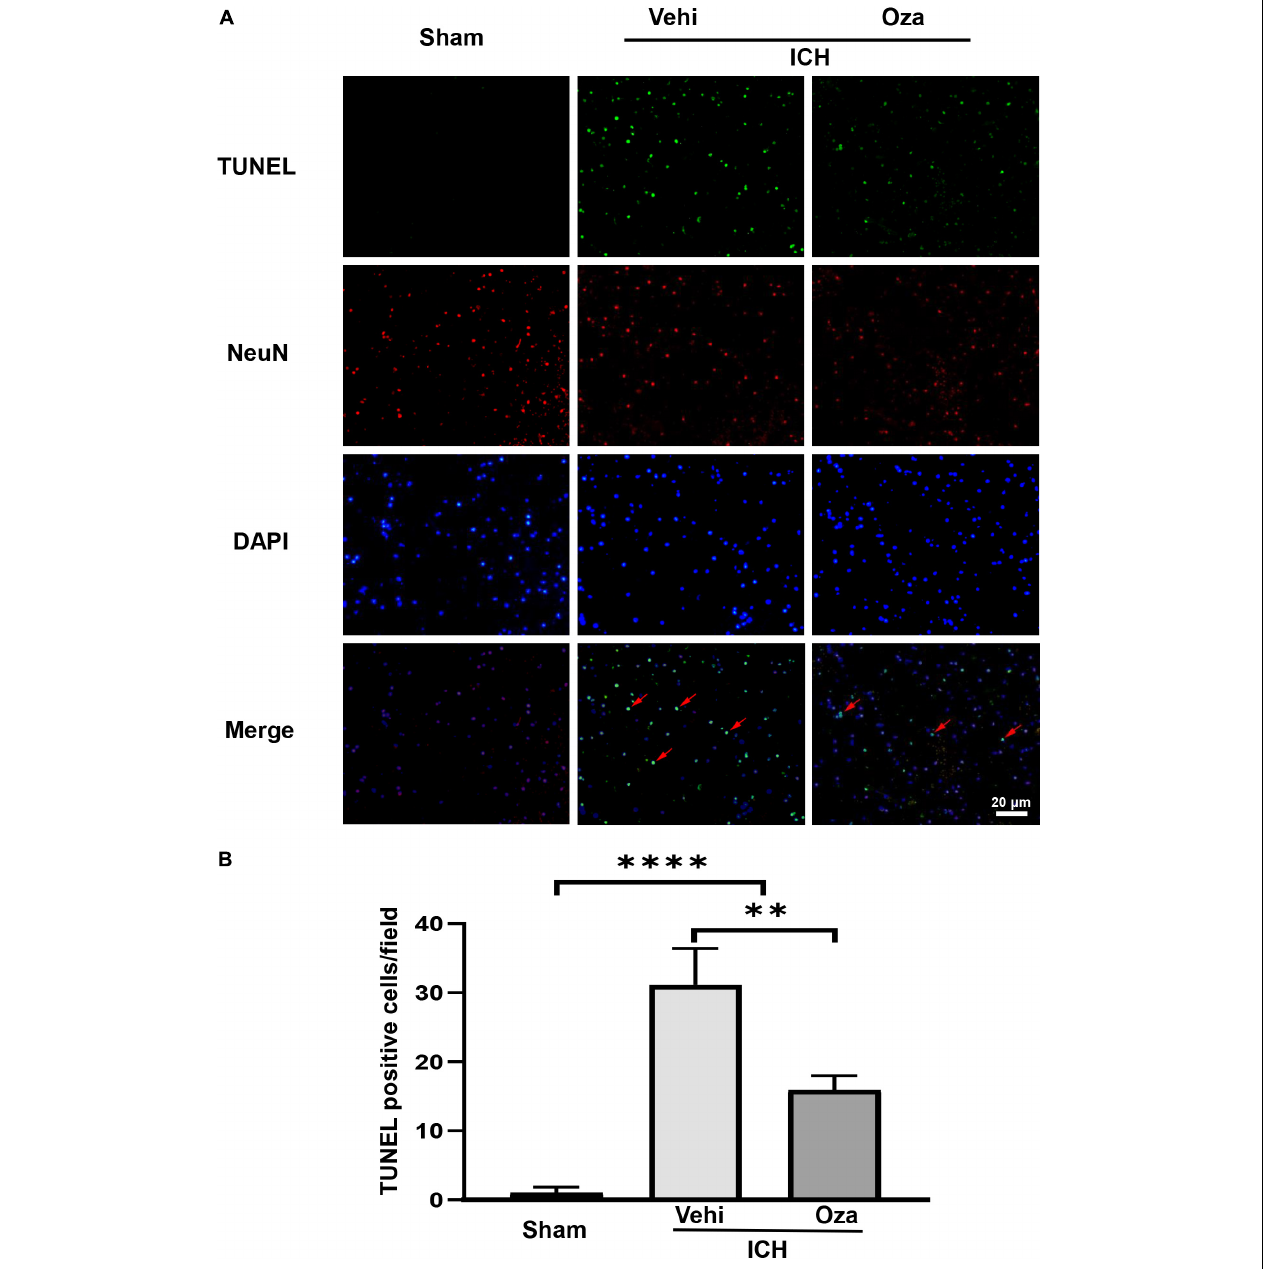
FIGURE 4 | The effects of Ozanimod on neuronal death in mice after ICH. (A) TUNEL staining was used to mark dead cells (green). Immunofluorescence staining with NeuN was used to mark neurons (red), with the red arrow demonstrating dead neuronal cells. (B) Immunofluorescent staining and statistical results of death of neurons with Ozanimod or vehicle administration in mice for 3 days after ICH. Data are presented as mean ± SD ( n = 6, Bar = 20 µ m). ∗∗ p < 0.01, ∗∗∗∗ p <